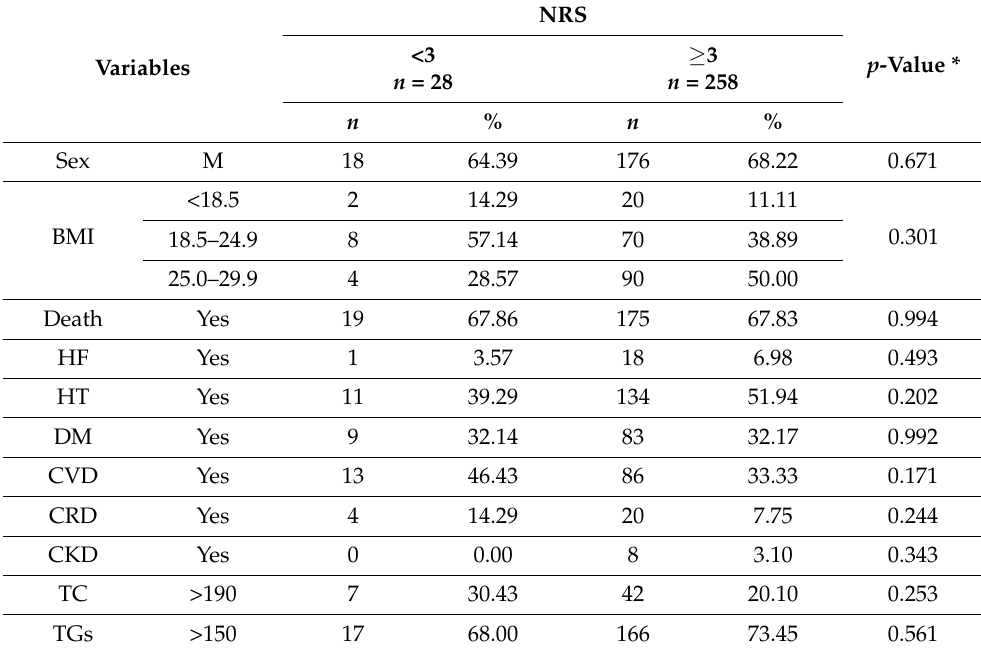
Table 4. Comparison of assessed parameters (qualitative variables) and NRS scores.